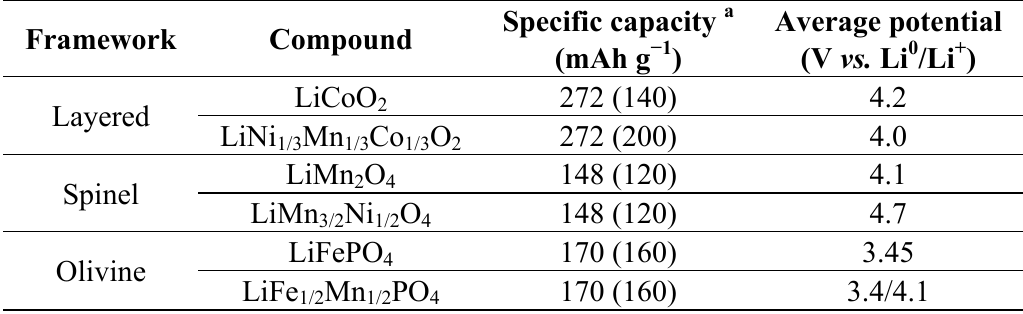
Table 1. Electrochemical characteristics of the three classes of insertion